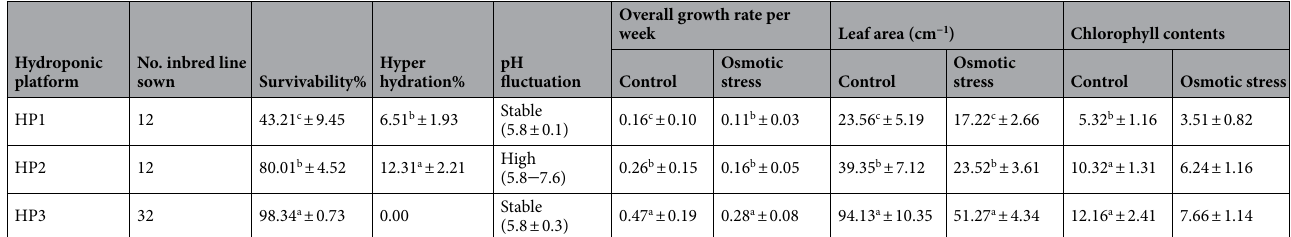
Table 1. Mean values of the morphological parameters evaluated for the sunflower germplasm maintained in the various hydroponic platforms. HP1 = Hydroponic platform with roots directly submerged in nutrient media; HP2 = Two pans with gravelanchoring substrate, HP3 = Two pans with glass beads anchoring substrate.